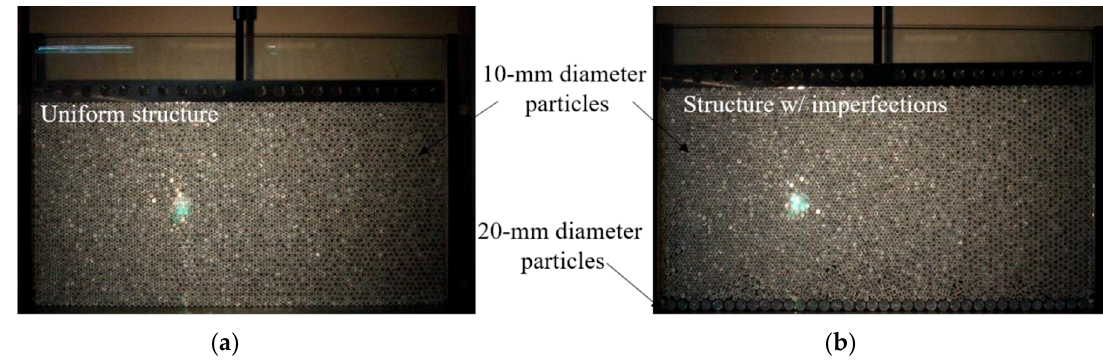
Figure 4. Stacked particle assemblies in a frame: ( a ) Uniform structure assembly with 10-mm diameter particles; ( b ) assembly with 10-mm diameter particles overlying 20-mm particles and with structural imperfections.